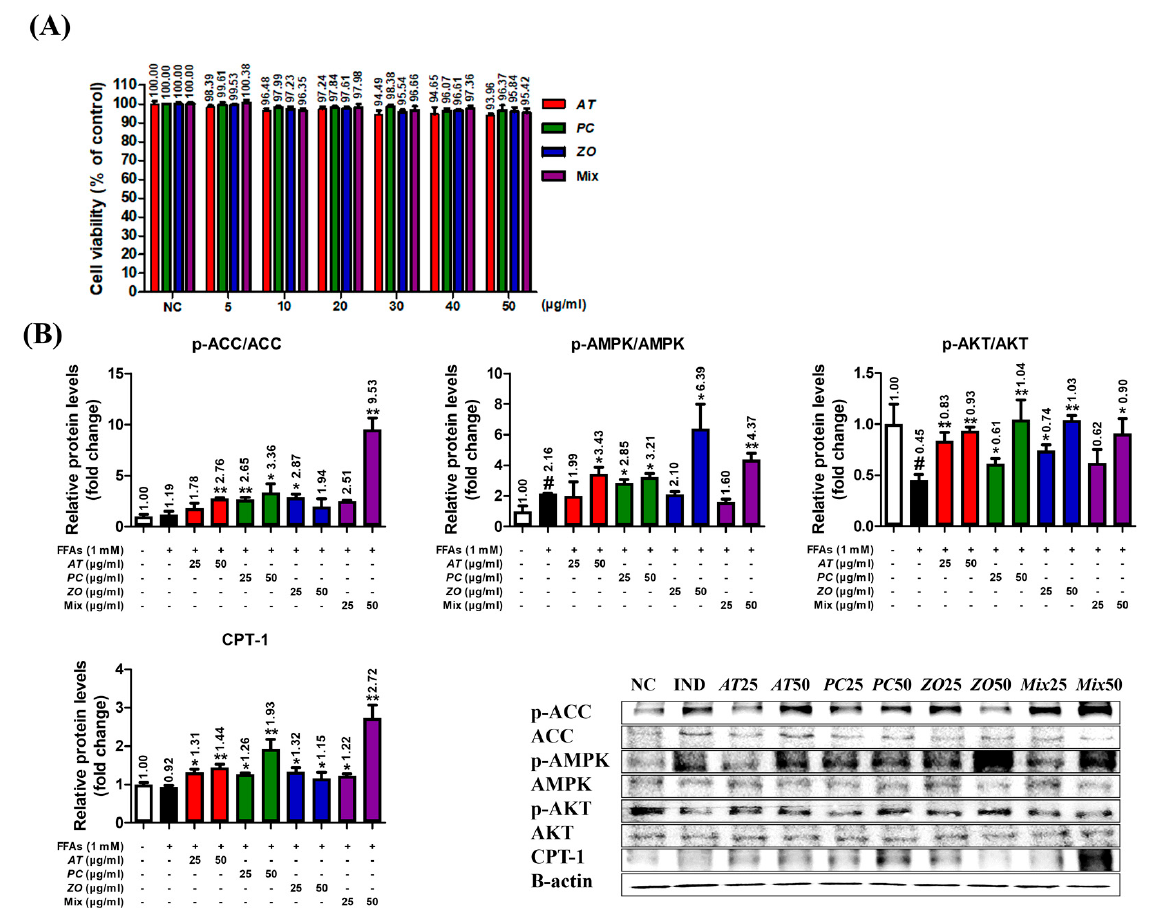
Figure 7. AT, PC, ZO, and MIX stimulate ACC, AMPK, and AKT phosphorylation in FFA-induced hepatic steatosis and activate CPT-1 related to fatty acid oxidation. HepG2 cells were incubated in the absence or presence of FFAs (1 mM) with AT, PC, ZO, and MIX for 24 h. ( A ) HepG2 cells were treated with various concentrations (0–50 µ g/mL) of AT, PC, ZO, and MIX for 24 h. The results are presented as means ± SDs of the percentages determined by three independent experiments versus the non-treated controls. ( B ) HepG2 cells were co-treated with each sample and FFAs for 24 h. Western blot analysis shows the effect on the phosphorylation of ACC and AMPK and AKT protein expression related to the energy metabolism and lipogenesis in FFA-induced hepatic steatosis HepG2 cells. The band intensities were measured by densitometry and normalized versus the intensities of the total forms and β -actin. The results are presented as the means ± SDs of three independent experiments. # p < 0.05 versus FFA-treated controls, and * p < 0.05, ** p < 0.01 versus FFA-treated HepG2 cells.